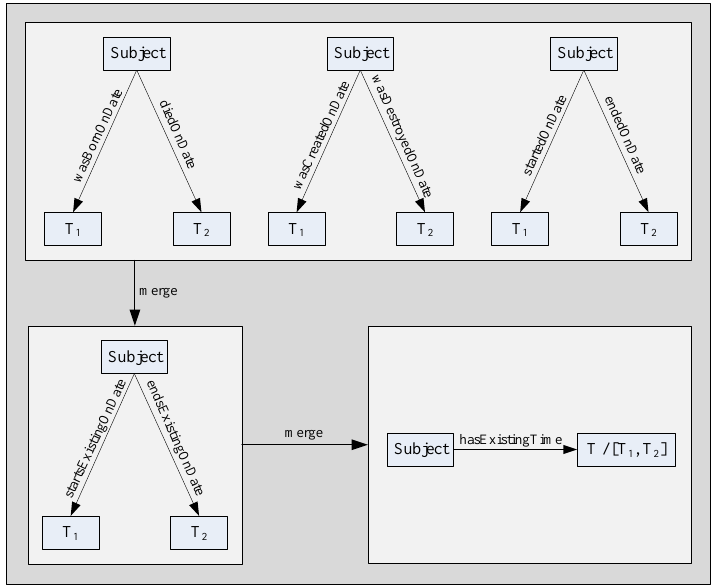
Figure 1. Representation model of temporal entities.